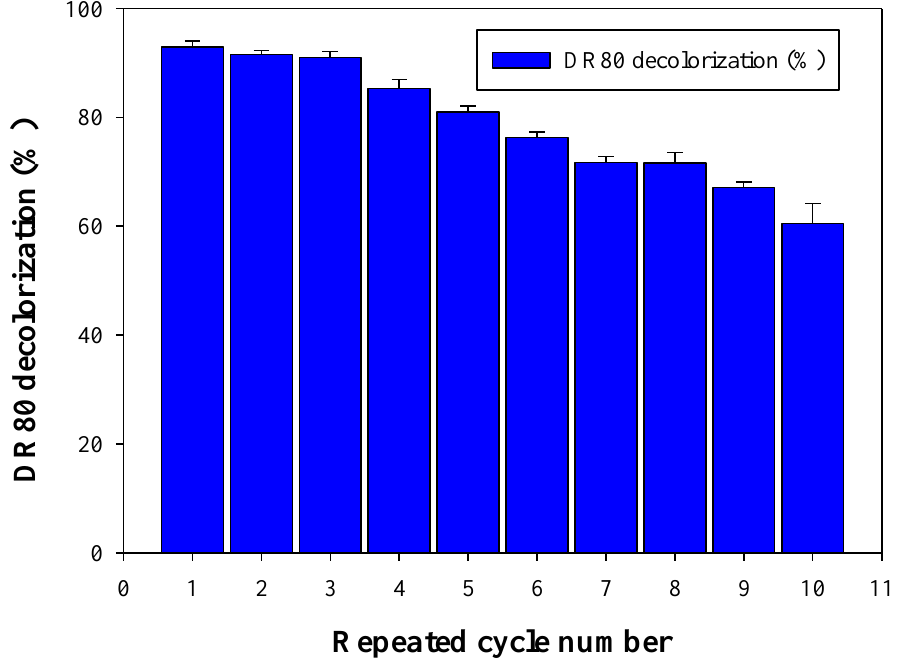
Figure 10. Repeated cycle removal of the DR80 by HNTs-Fe 3 O 4 -CTs-S-S-Laccase in the presence of the redox mediator ABTS.